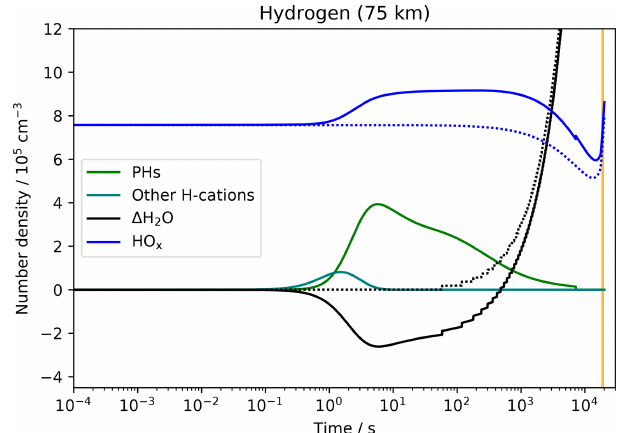
Figure 8. Similar to Fig. 7 but here at 80km and additionally show- ing the change of the total hydrogen amount in the form of H 2 (pur- ple